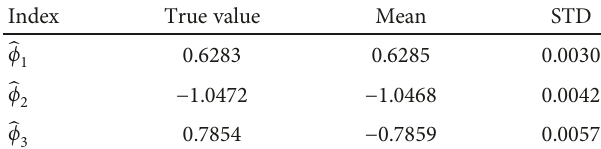
Figure 2: RMSE versus SNR.